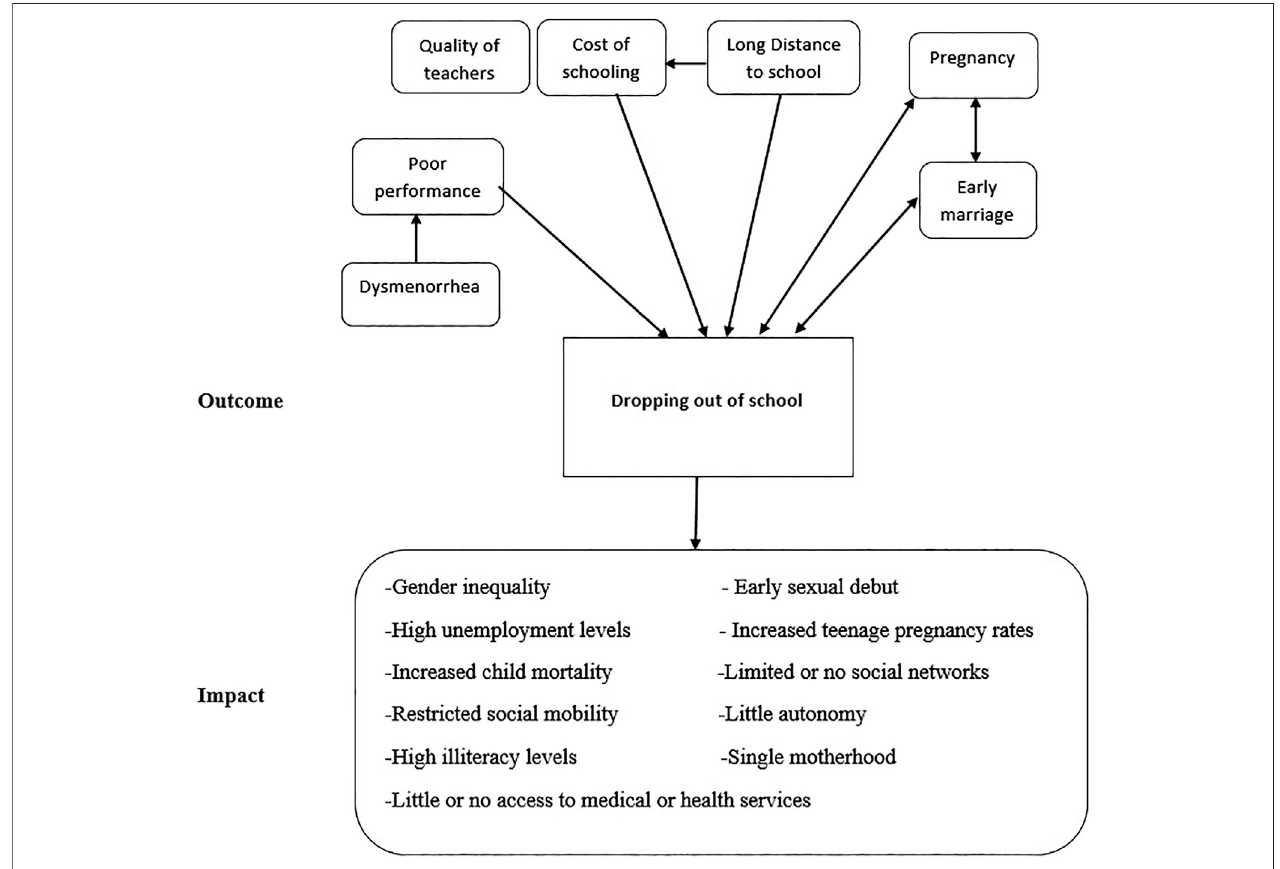
FIGURE 1 | Iterative logic